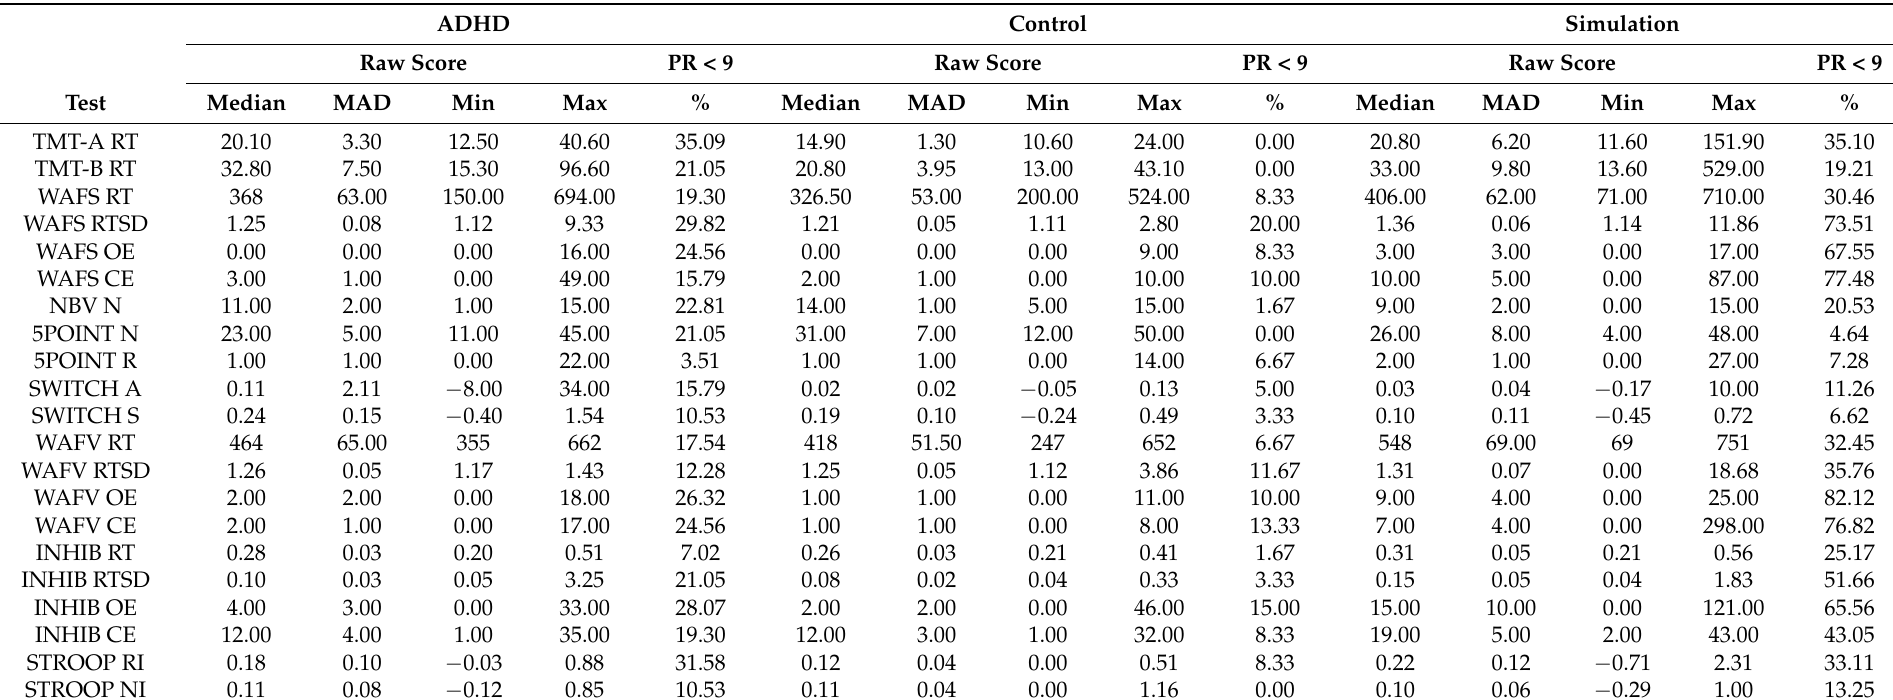
Table 2. Summary statistics on neuropsychological test